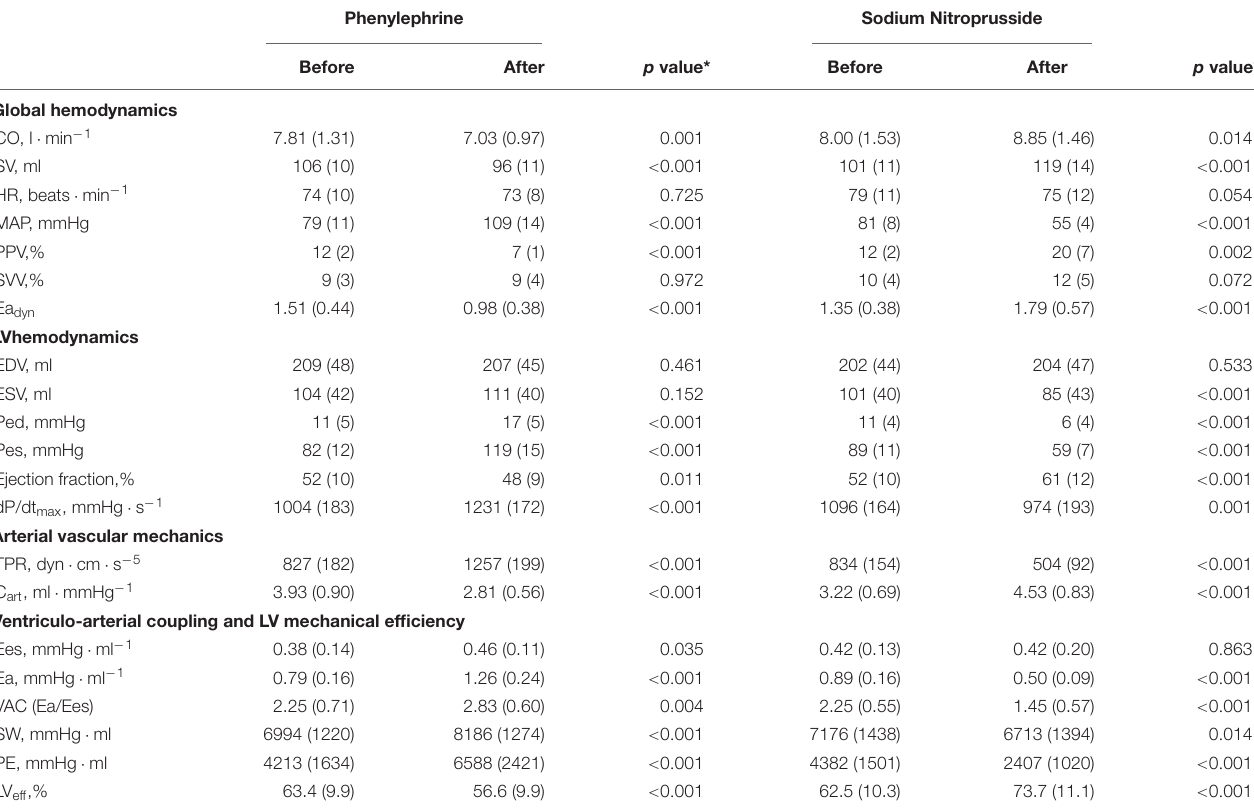
TABLE 1 | Hemodynamic variables during afterload